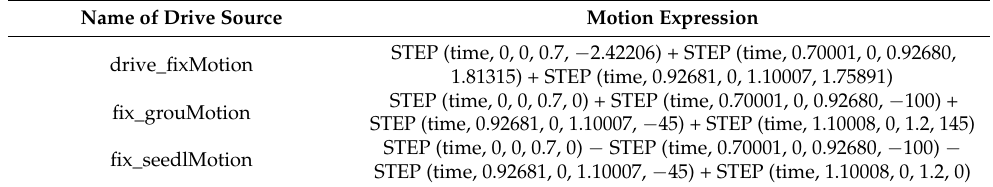
Table 4. Table of motion equations.